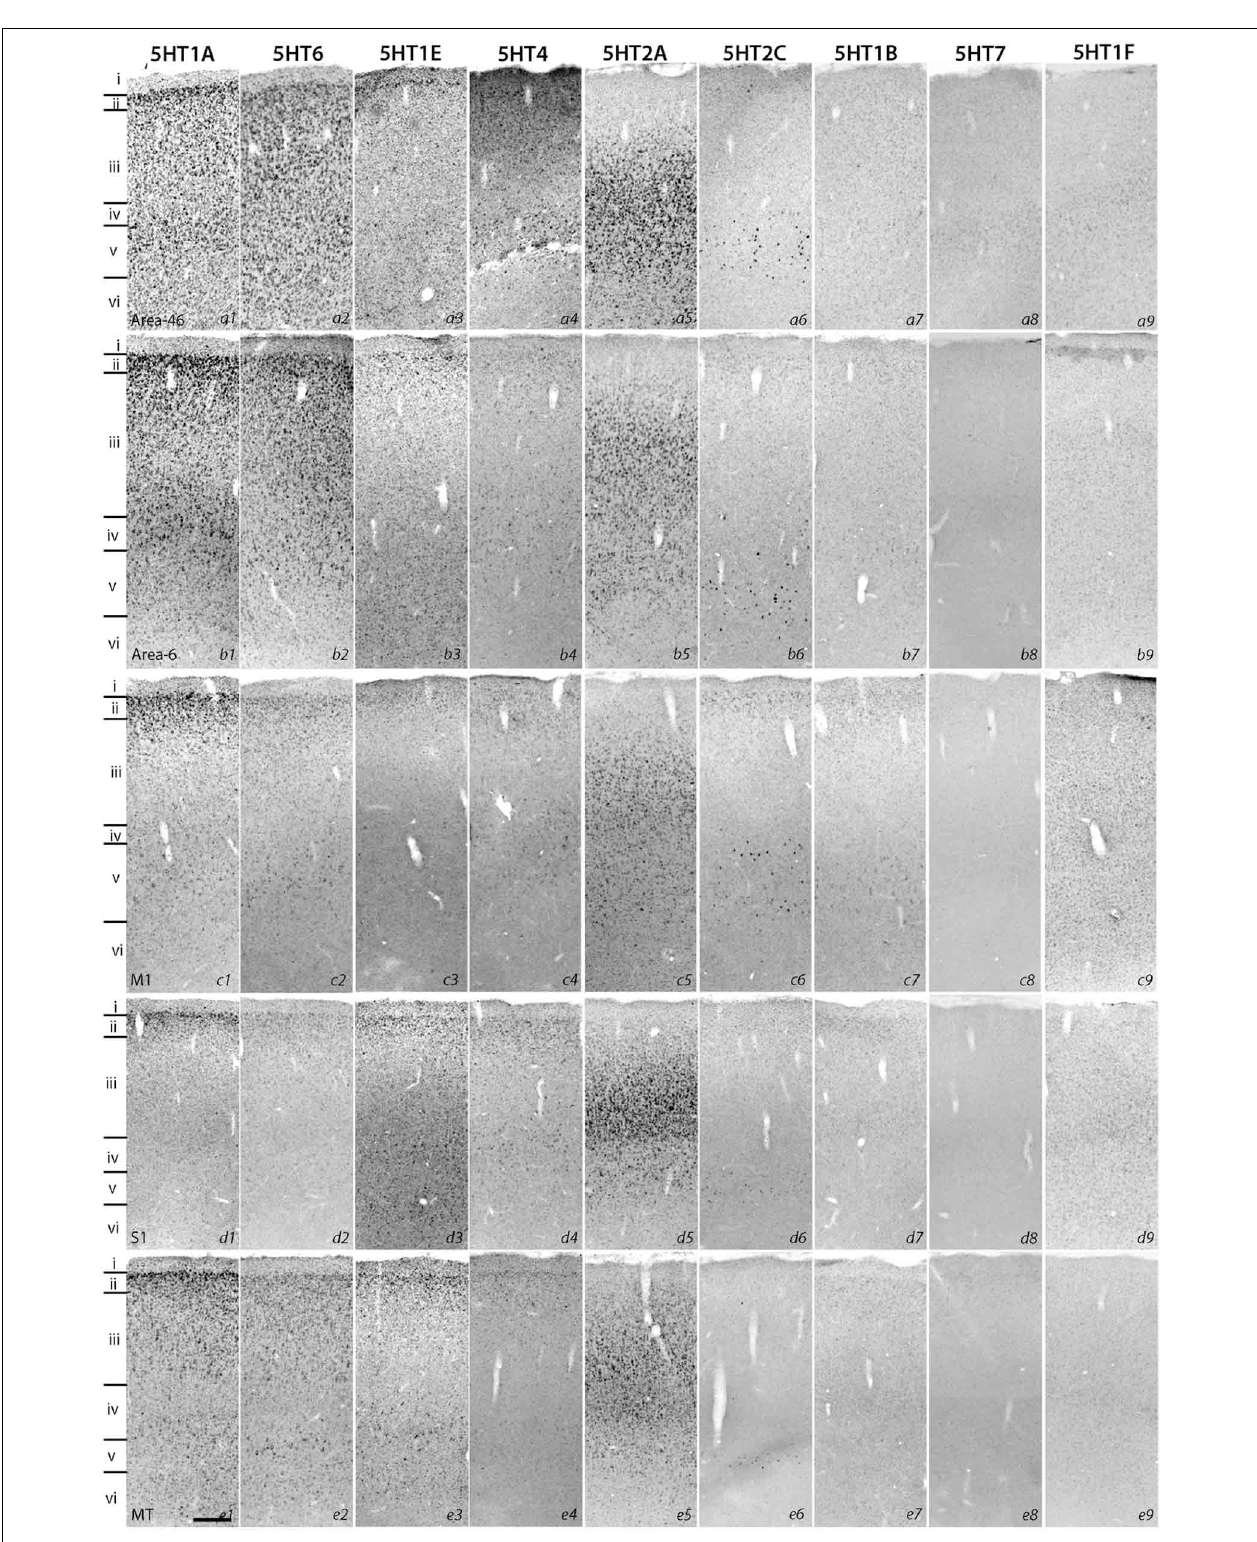
FIGURE 1 | ISH expression profiles of 5HTRs in cortex. Area 46, area 6, primary motor cortex (M1), primary somatosensory cortex (S1), and V5 (MT). Layers identified by Nissl staining (not shown)